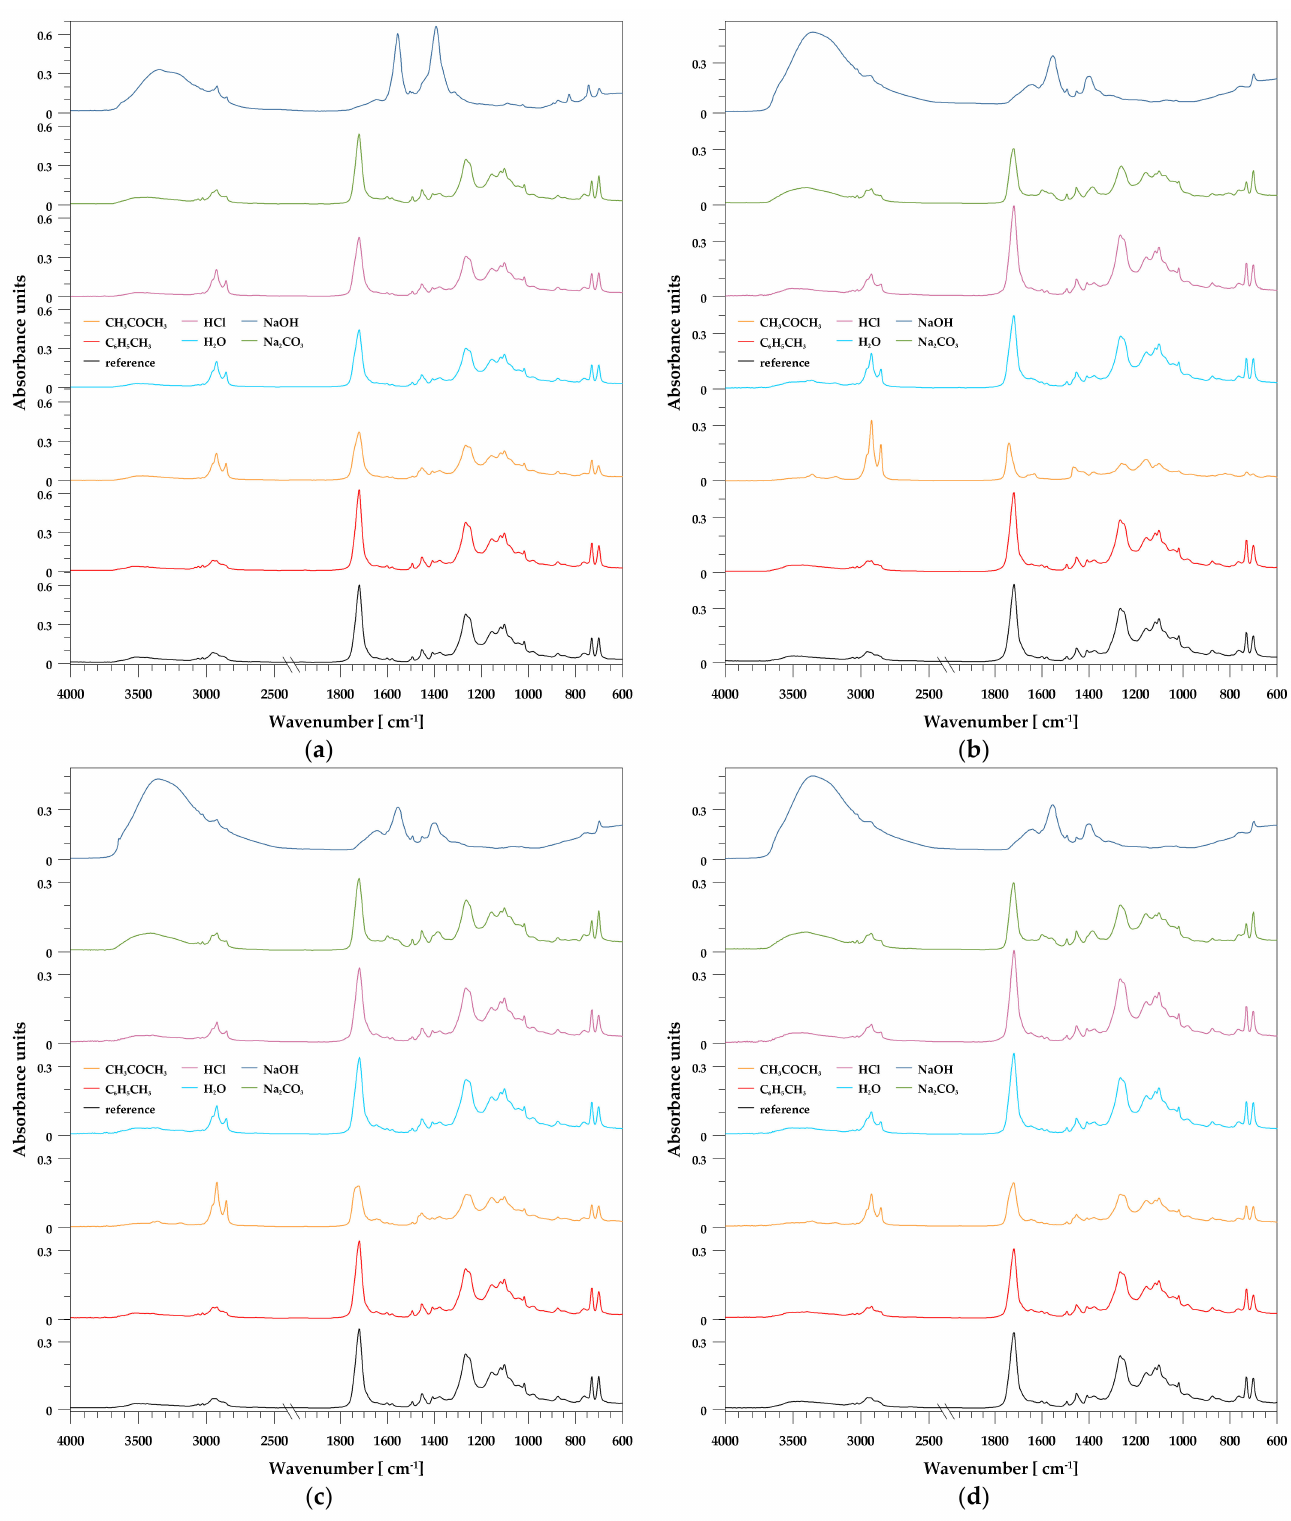
Figure 4. FT-IR/ATR spectra of the UPR/PSP composites before and after the immersion test. ( a ) Pure UPR; ( b ) UPR + 10; ( c ) UPR + 20; ( d ) UPR +